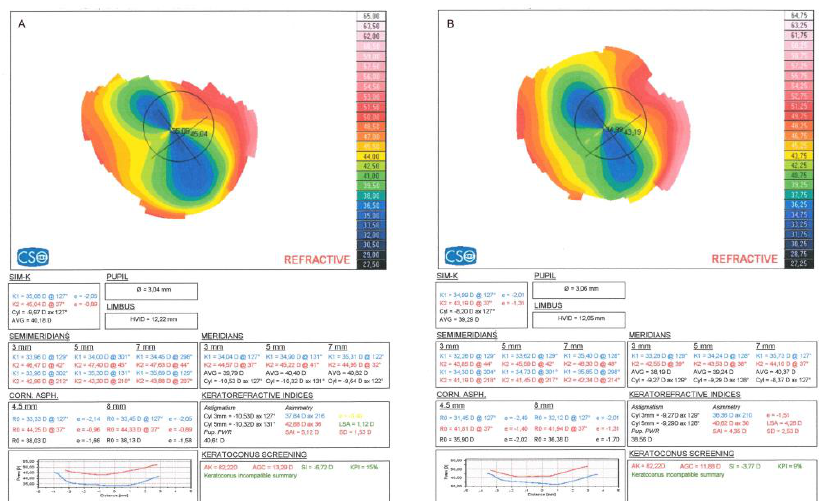
Figure 2. Corneal topography results before surgery ( A ) and at 12 months ( B ).